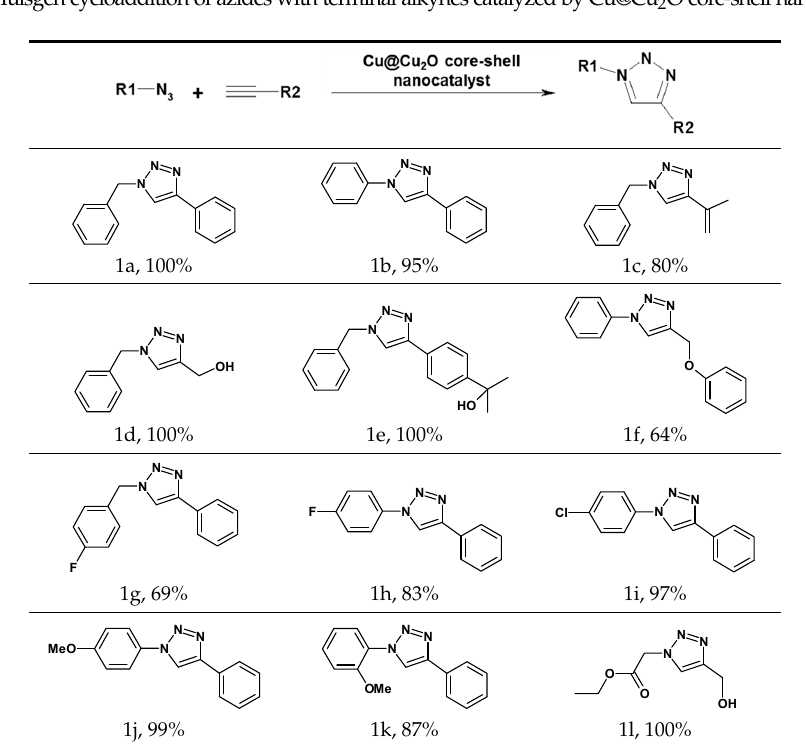
(Table 1, 1d and 1e). The ortho- and para-methoxy group respectively gave the expected